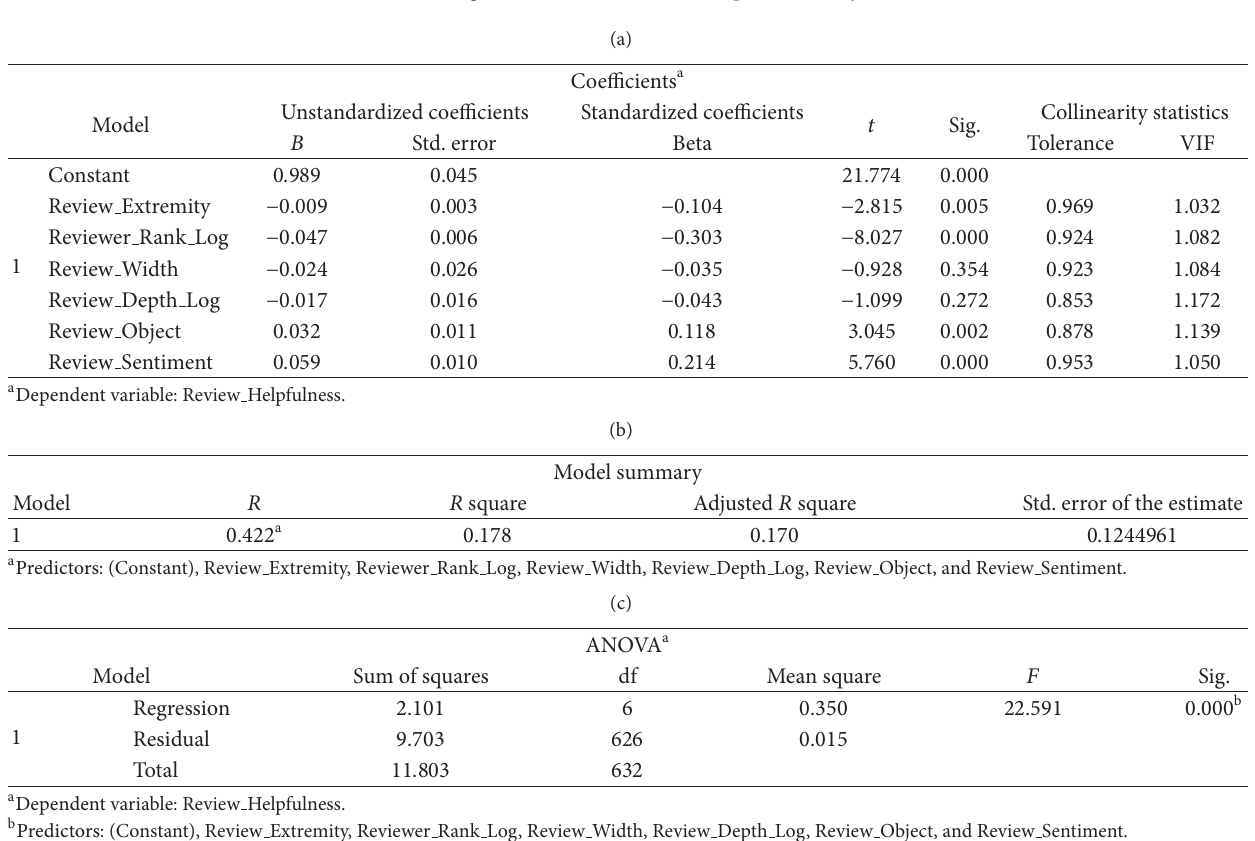
Table 9: Regression results for review helpfulness analysis.